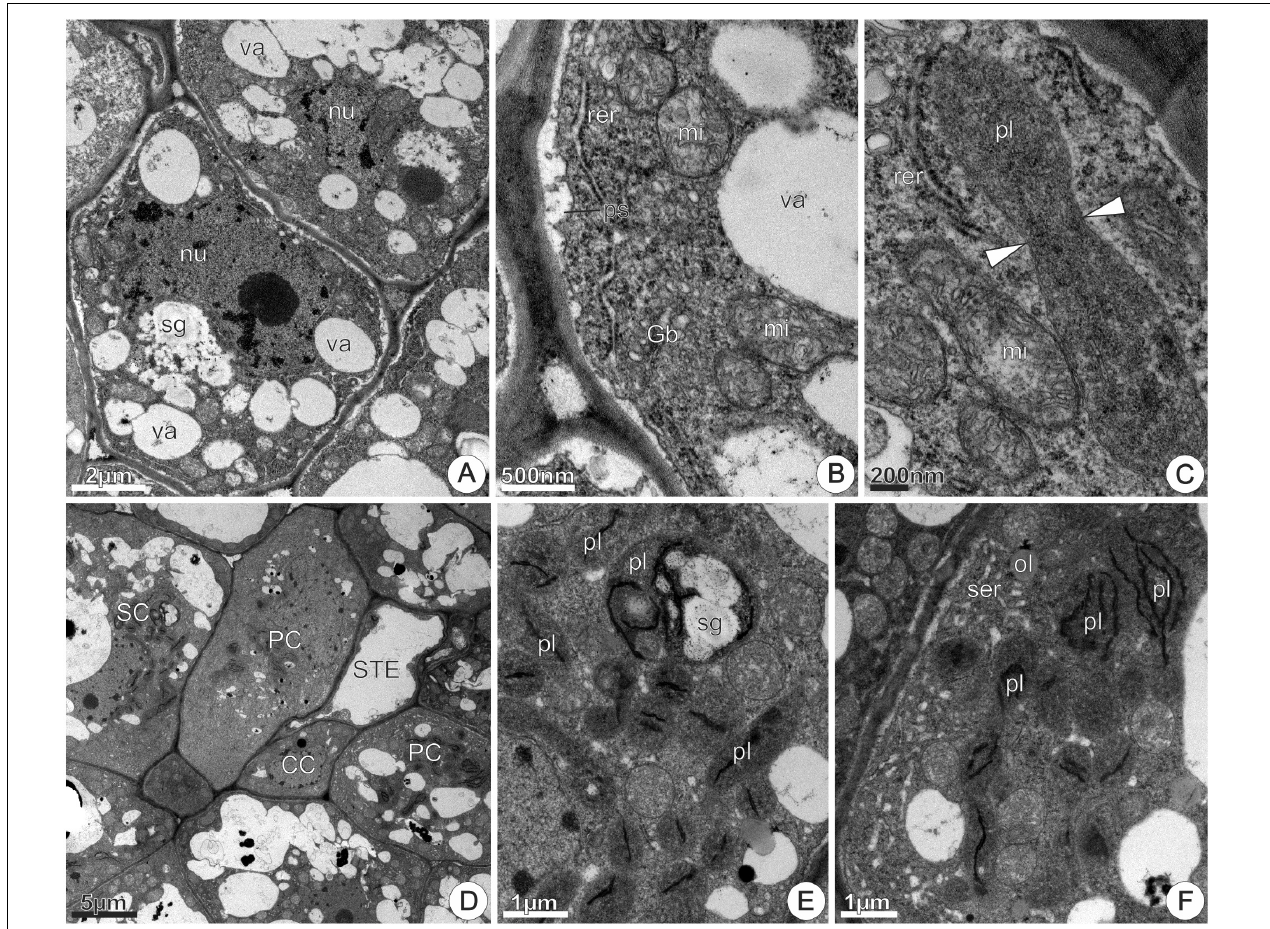
FIGURE 9 | TEM micrographs of the disk from Jacaranda oxyphylla nectariferous flowers, at 24 h of anthesis. (A–C) Nectary parenchyma. (A) General aspect showing vacuolated cells with prominent nucleus and evident nucleolus, degenerating amyloplast and merged vacuoles; (B) detail of (A) showing cytoplasm rich in polyribosomes, mitochondria, extensive RER and Golgi bodies located in the peripheral cytoplasm, and developed periplasmic spaces; (C) elongated plastid with clear median constriction (arrowheads) surrounding with RER elements and mitochondria. (D–F) Subnectary parenchyma. (D) General view of the subnectary parenchyma and phloem cells; (E) detail of (D) showing chloro-amyloplasts and undifferentiated plastids in parenchyma cell; (F) plastids with thylakoid-like membranes and dilated SER elements assembled in the peripheral cytoplasm of phloem parenchyma cell. CC, companion cell; Gb, Golgi body; mi, mitochondria; nu, nucleus; ol, oil; PC, phloem parenchyma cell; pl, plastid; ps, periplasmic space; rer, rough endoplasmic reticulum; ser, smooth endoplasmic reticulum; sg, starch grains; SC, subnectary parenchyma cell; STE, sieve tube element; va, vacuole.